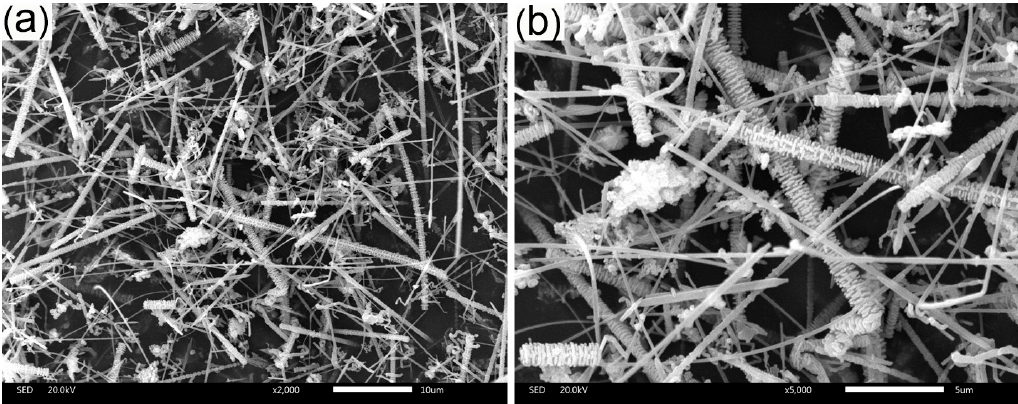
Figure 1. Scanning electron microscopy (SEM) images of SiC whiskers (SiCw): ( a ) low magnification; ( b ) high magnification. ( b ) high